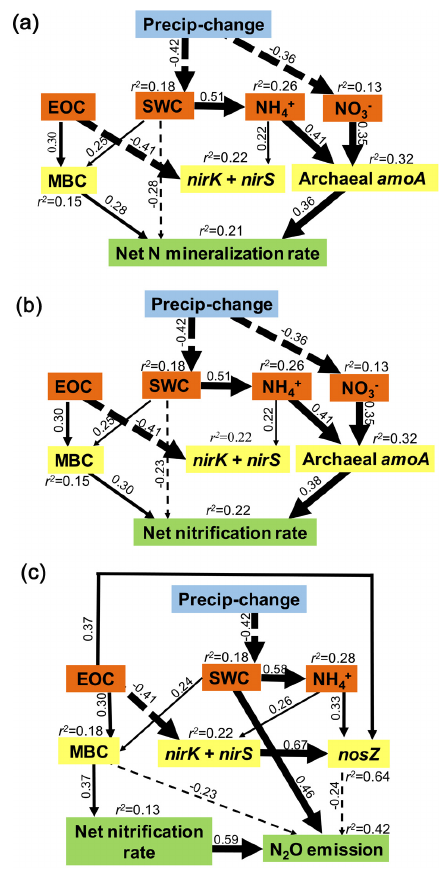
Figure 5. Path diagrams demonstrating the effects of soil physico- chemical properties and functional-gene abundance on net nitrifica- tion, N mineralization and N 2 O efflux rates in response to precipi- tation change (precip-change) over 2 years. Numbers adjacent to ar- rows are path coefficients, which indicate the relationships between the two variables on both sides of the arrows. Solid and dashed lines represent positive and negative paths, respectively. The r 2 above or below each response variable in the model denotes the proportion of variance which could be explained. The size of the lines indicates significant levels of path